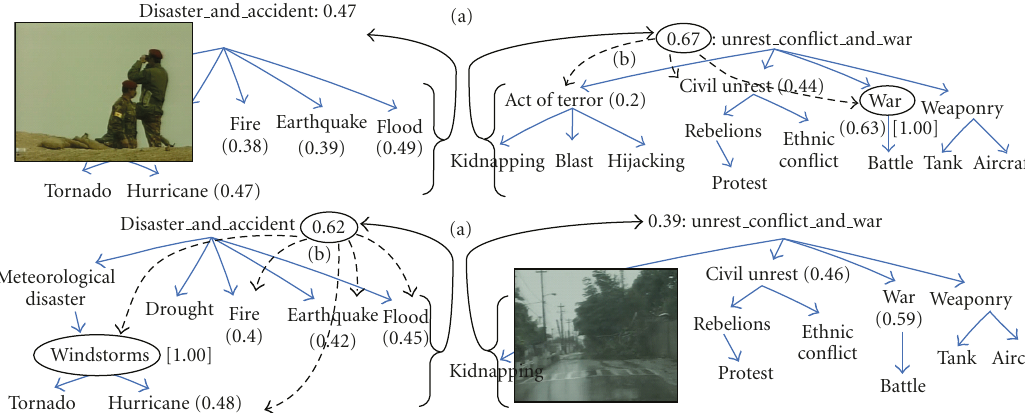
Figure 9: Examples of the two-stage process for combining all the individual modality analysis results that is part of the Generalized Concept